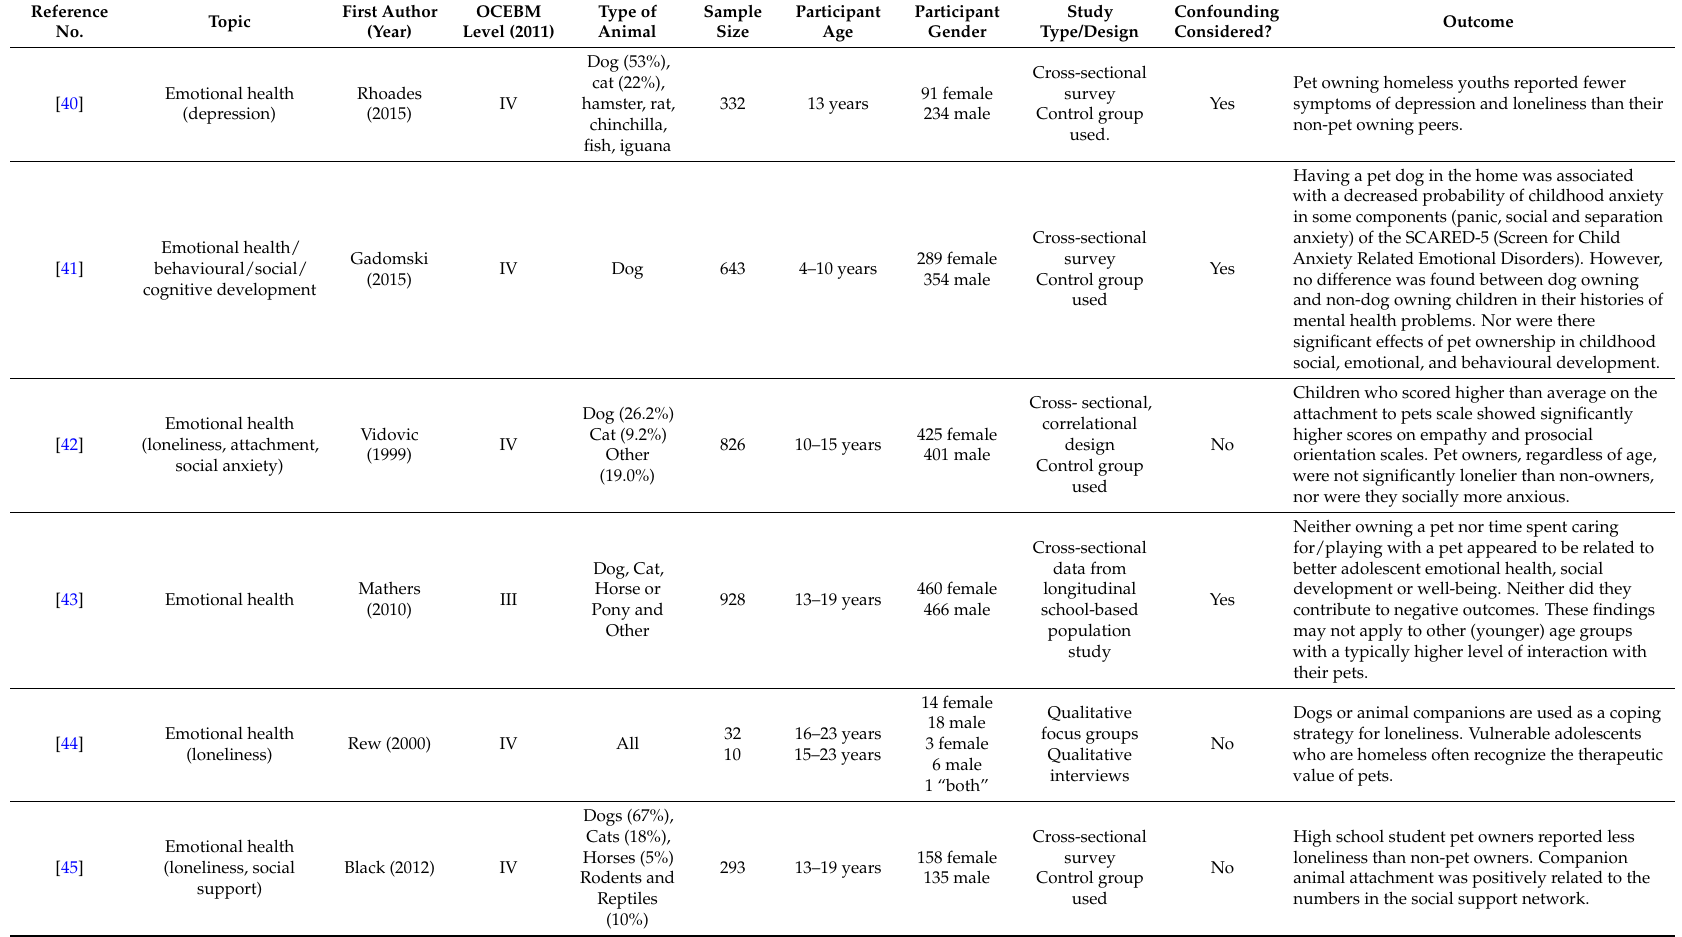
Table 2. Evidence for the impact pets have on child and adolescent